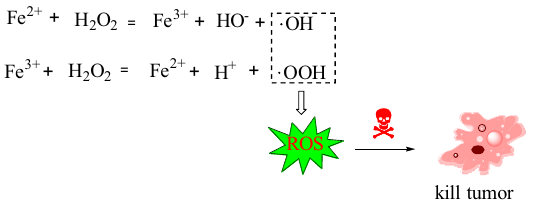
Figure 3: The principle of FT for killing cancer